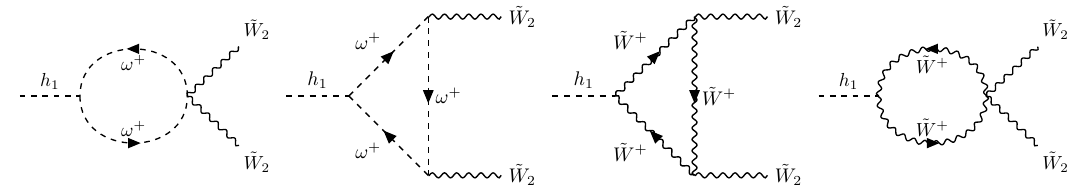
Figure 2. Feynman diagrams for the Higgs invisible decay to the dark